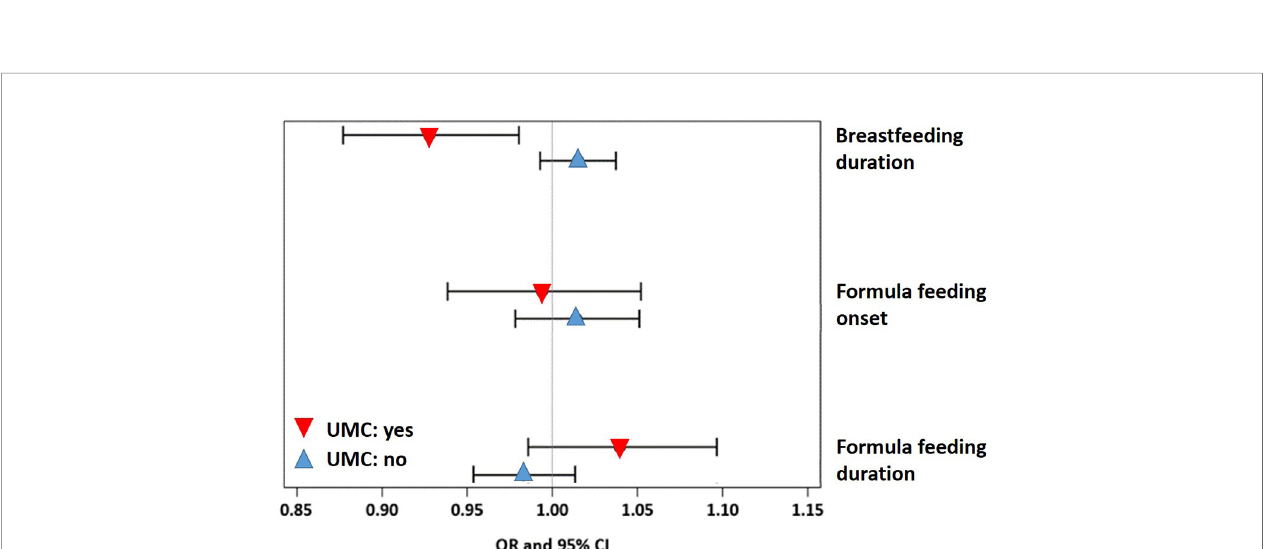
FIGURE 9 | Associations of asthma with breastfeeding and formula feeding strati fi ed by